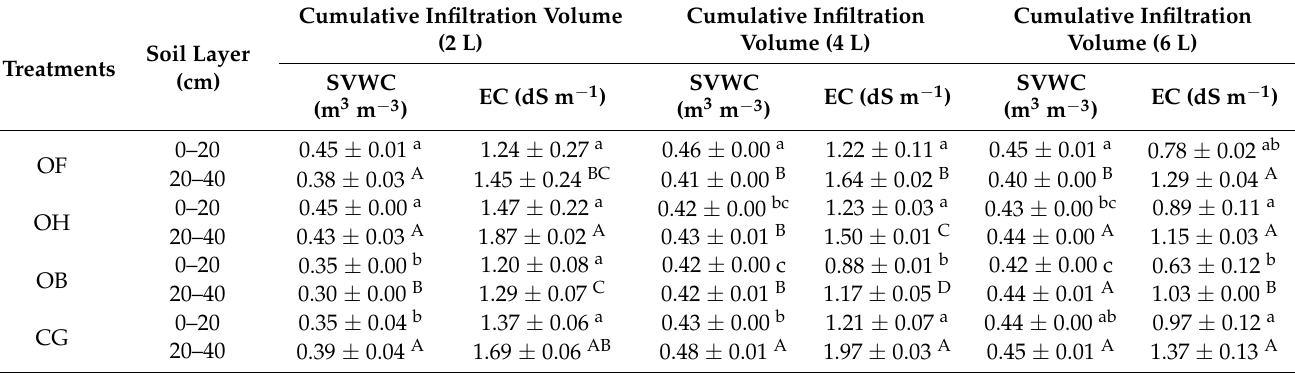
Table 4. Variation of SWC and EC under different cumulative infiltration water amounts.